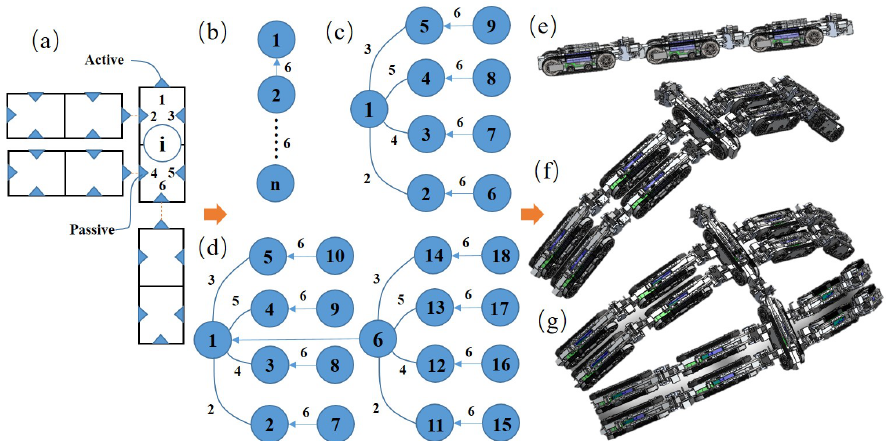
Figure 8. SMMRob topology and diversity of structures. ( a ) Allowed active and passive docking panels. ( b ) Linear configuration topology. ( c ) Quadruped configuration topology. ( d ) Quadruped configuration topology with a spine. ( e ) Snake-like structure. ( f ) Quadruped structure. ( g ) Quadruped structure with a spine.